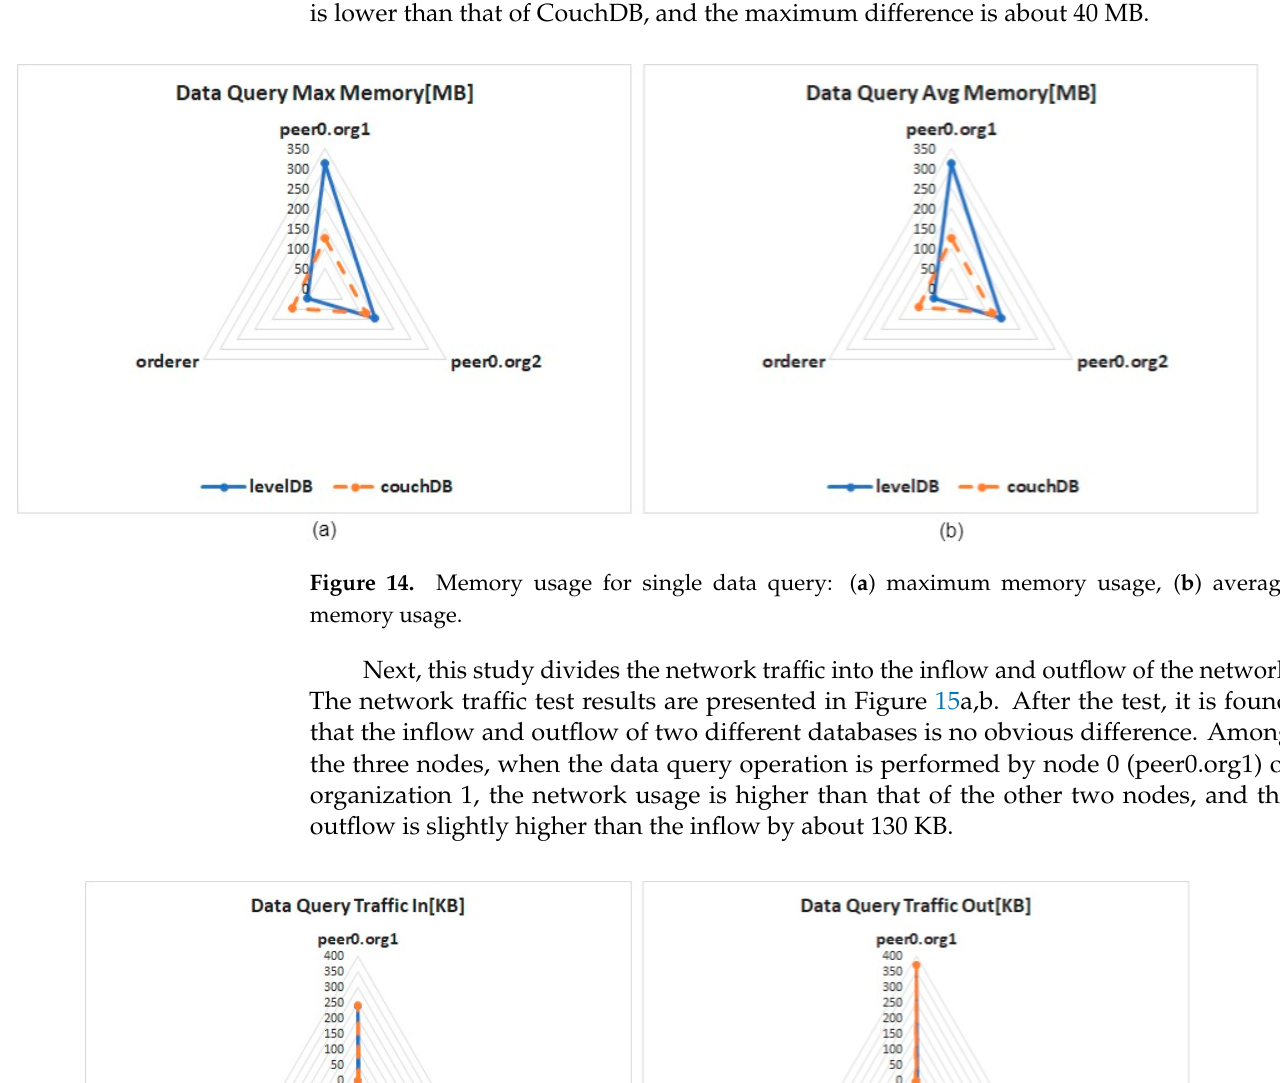
Figure 13. CPU usage for single data query: ( a ) maximum CPU usage, ( b ) average CPU usage.